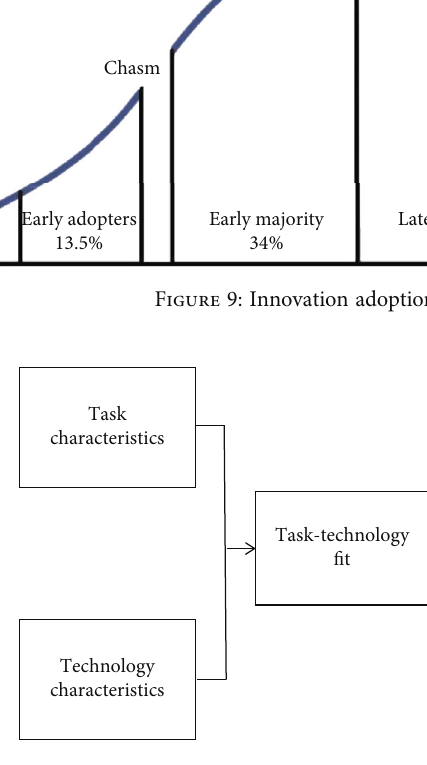
Figure 10: Task-technology fi t